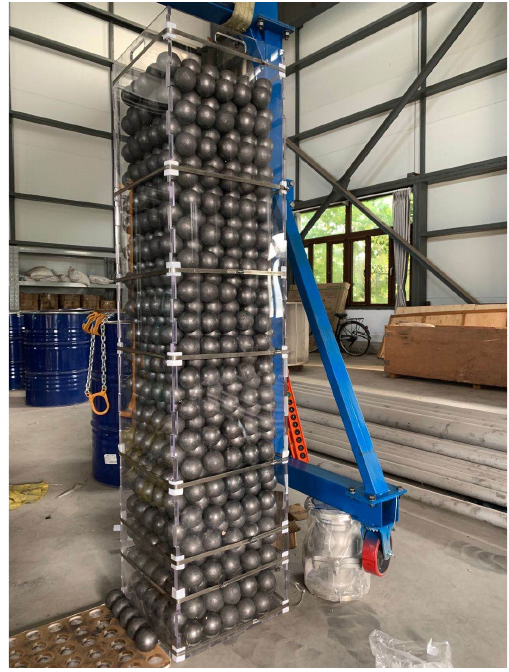
Figure 7. The illustration of pebble